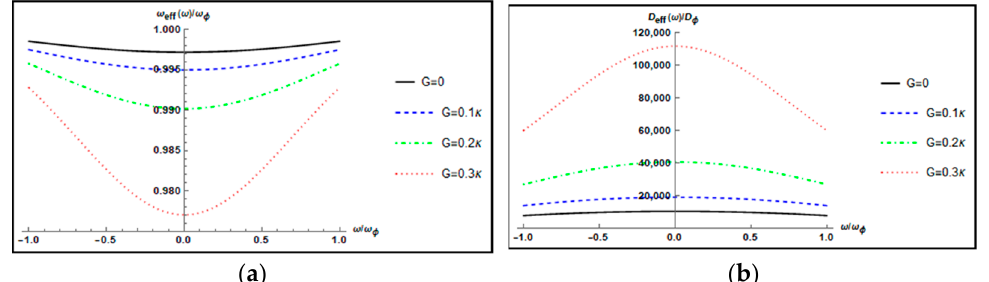
Figure 2. Plot of ( a ) the normalized effective resonance frequency ω ef f ( ω ) / ω φ and ( b ) the normalized effective damping rate D ef f ( ω ) / D φ of the mechanical torsional pendulum versus the normalized frequency ω / ω φ for different parametric gains G = 0, 0.1 κ ,0.2 κ ,0.3 κ when ∆ = ω φ , θ = 0, and 𝑙 = 20.